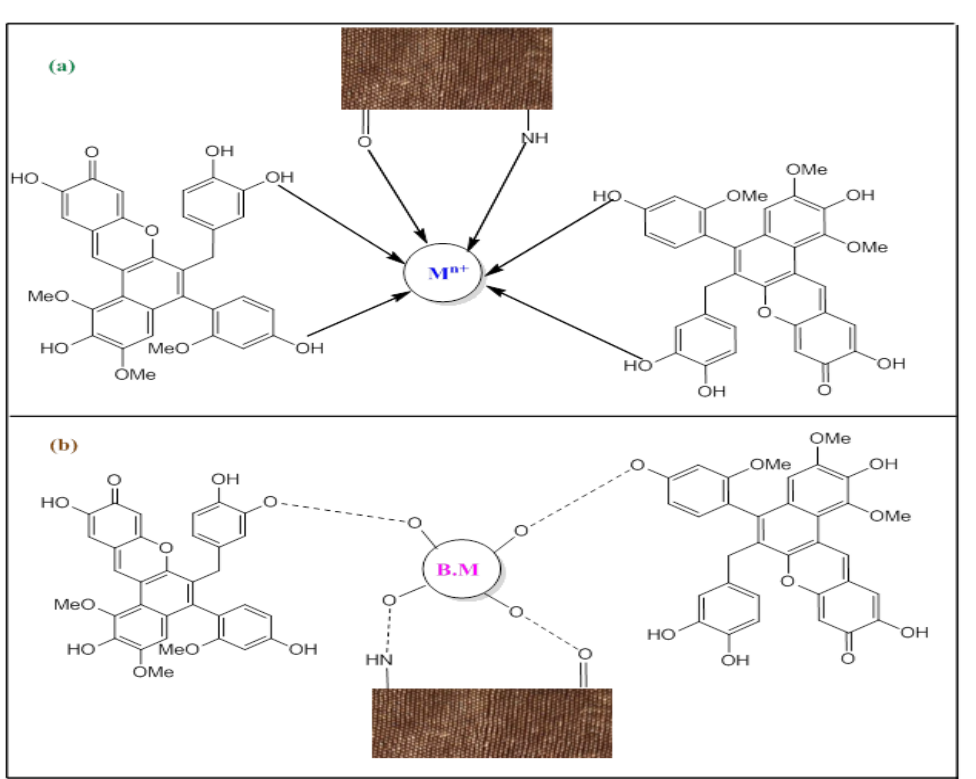
Figure 6. ( a ) Pre-bio mordant of silk fabric with red sandalwood (RSW) powder at optimized conditions. ( b ) Post-bio mordant of silk fabric with red sandalwood (RSW) powder at optimized conditions.